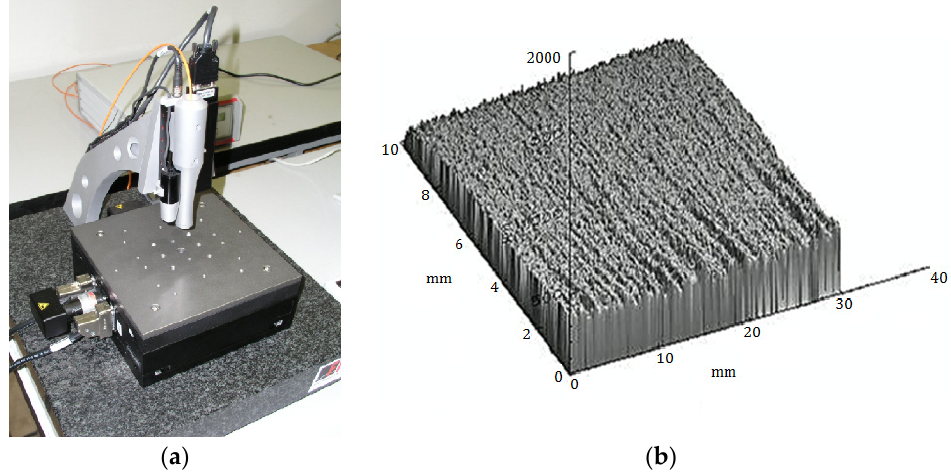
Figure 1. ( a ) General view of the optical profilometer FRT MicroProf produced by FRT; ( b ) 3 D image of cutting wall.